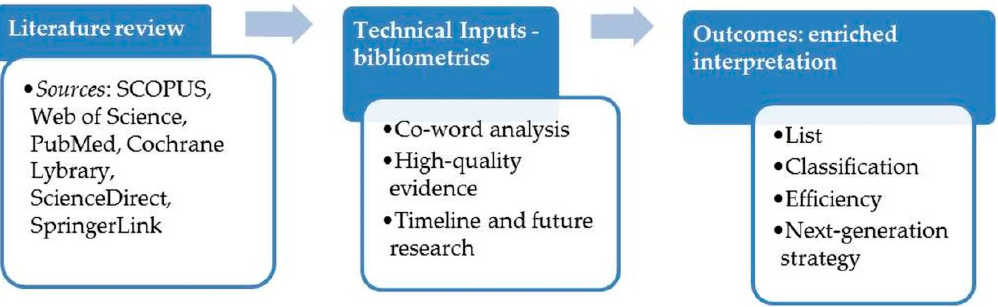
Figure 1. Overview of the Synthetic Antioxidants Progression Model.